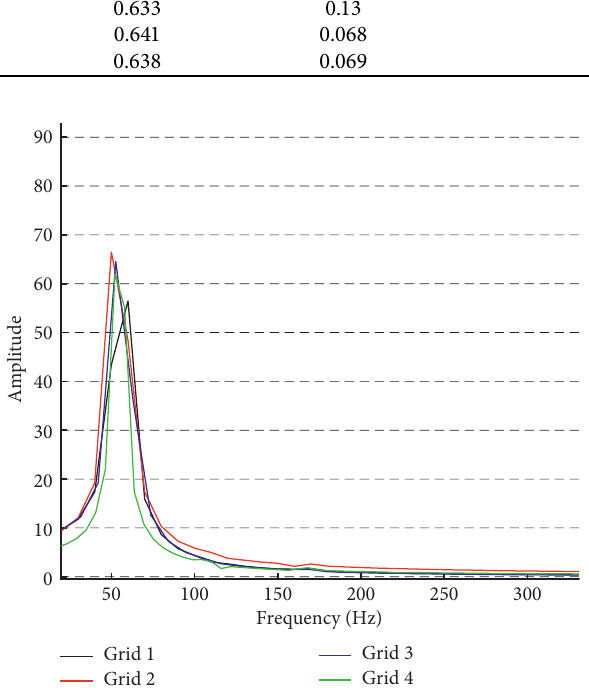
Figure 20: Lift frequency with different grids of five-tube bundles.